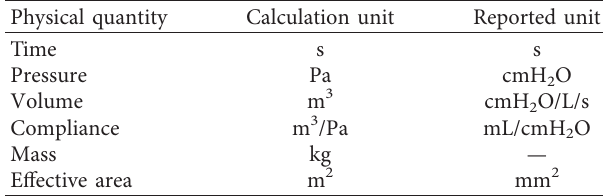
Table 1: The units of basic physical quantity.